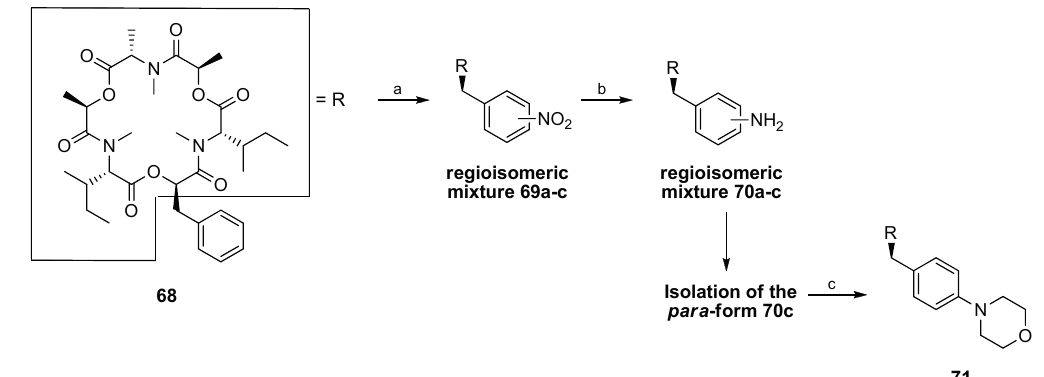
Scheme 6. Derivatization of enniatin analogue 68 .